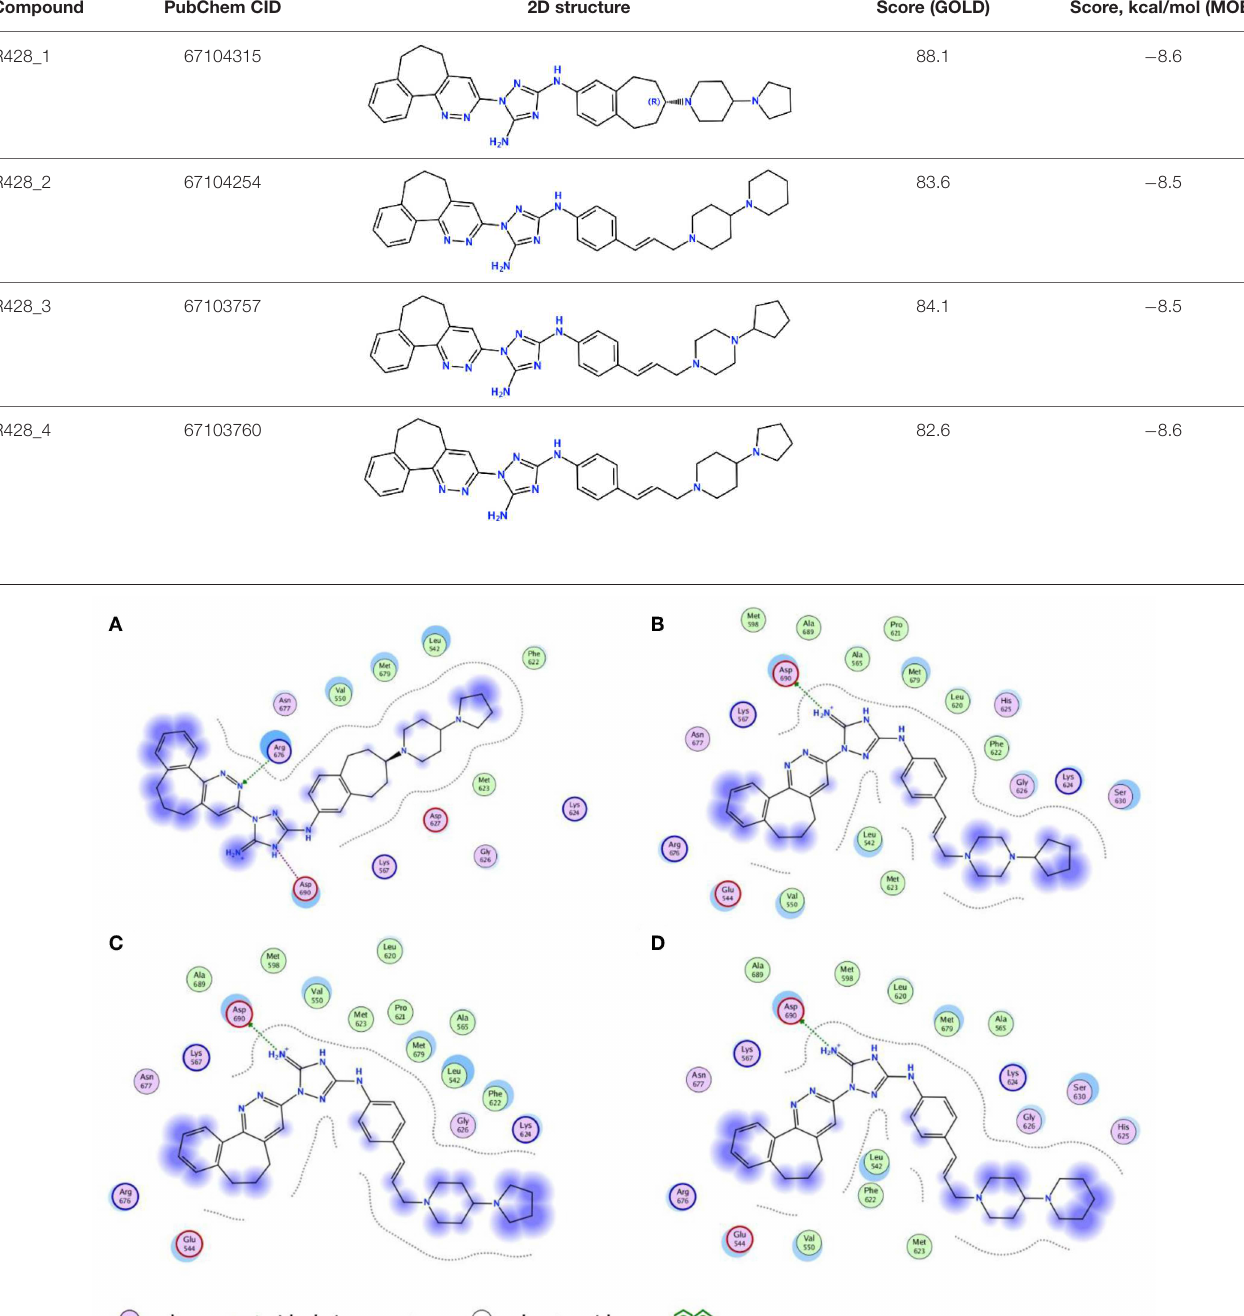
Frontiers in Chemistry |